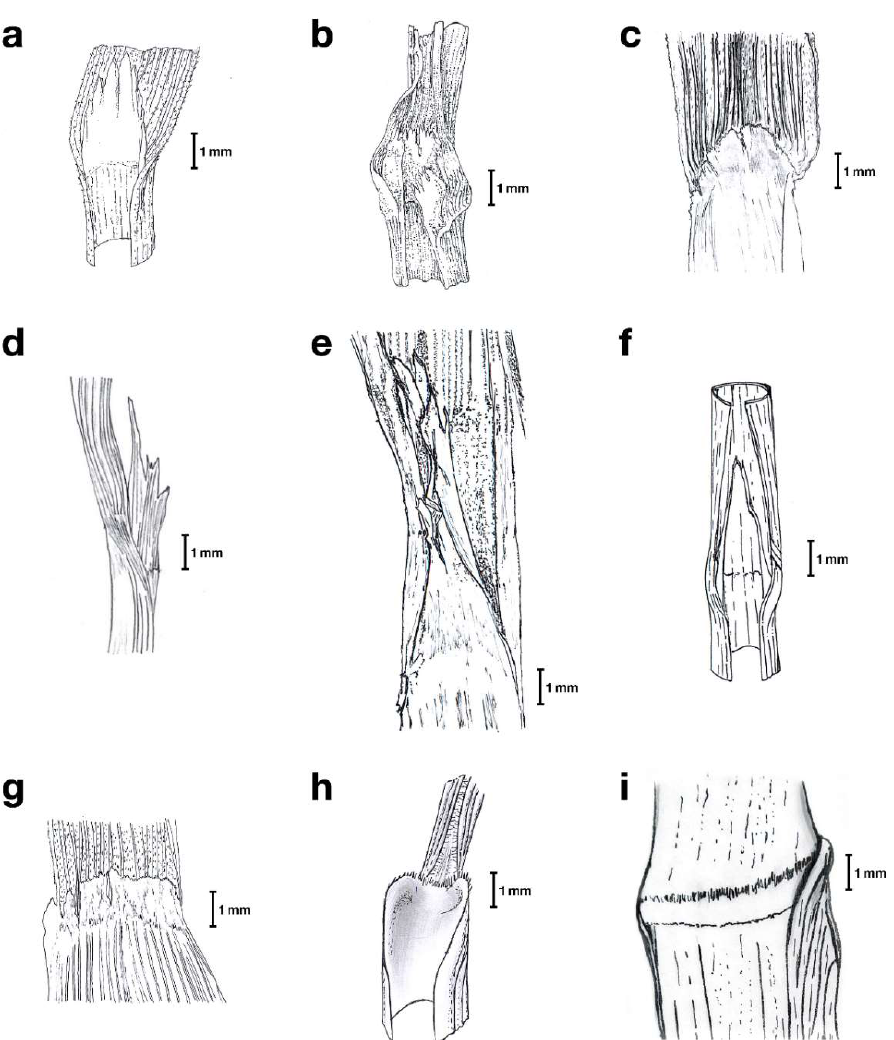
Figure 1. Ligule shape of representative species of Mesoamerican and South American broad-leaved Festuca taxa analyzed morphologically in this study. F . subgen. Subulatae sect. Glabricarpae : F. venezuelana ( a ); F . subgen. Drymanthele s. l .: F. superba ( b ); F . subgen. Subulatae sect. Glabricarpae : F. breviglumis ( c ); F . subgen. Asperifolia : F. asperella ( d ); F . subgen. Erosiflorae : F. quadridentata ( e , f ); F . subgen. Drymanthele sect. Ruprechtia : F. amplissima ( g ); F. subgen. Coironhuecu ( subgen. nov .): F. argentina ( h ); F . subgen. Mallopetalon : F. fimbriata ( i ). Drawings by José Alfredo Hidalgo-Salazar ( a – h ) and María Fernanda Moreno-Aguilar ( i ). (( a , f ): modified from Stančík and Peterson [31]; ( b ): modified from Türpe [49]; ( c ): Peterson P. M. and Rosales O. 16117, US-3524155; ( d ): Dziekanowski et al., 2022, MO-2107299 (isotype); ( e ): Laegaard S. 55567, AAU; g : Peterson P. M. and Herrera-Arrieda Y. 16150, US-3524157; ( h ): modified from Ospina [34]; ( i ): Kostling M. UZ 498.08).